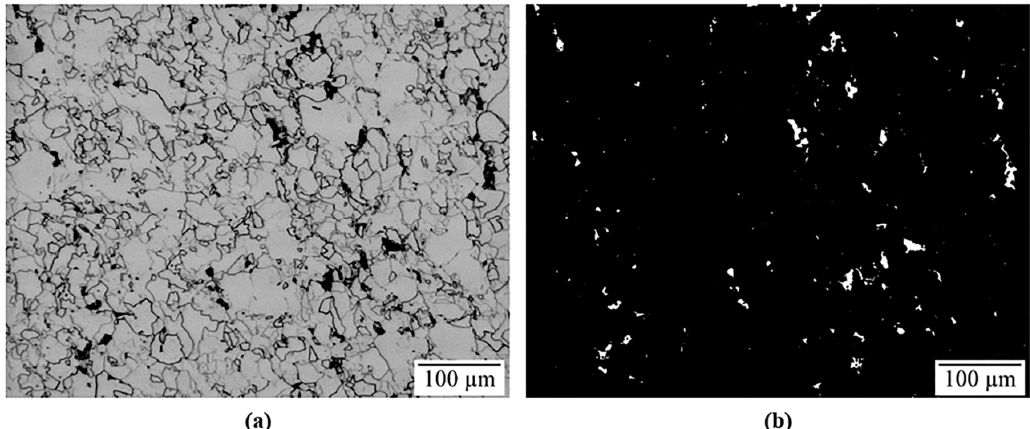
Figure 7. Example of the image thresholding process used to determine the area fraction of constituent phases in mixed microstructures: ( a ) original light optical microscopy (LOM) micrograph, where light etched regions represent polygonal ferrite and dark etched regions represent the secondary phase constituents, and ( b ) processed image, where black pixels represent polygonal ferrite and white pixels represent the secondary phase constituents.